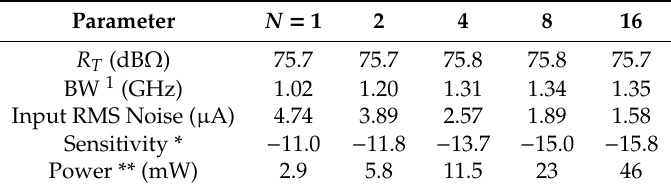
Table 1. Summary of the simulation results using the sliced-PD technique with different numbers of slices.